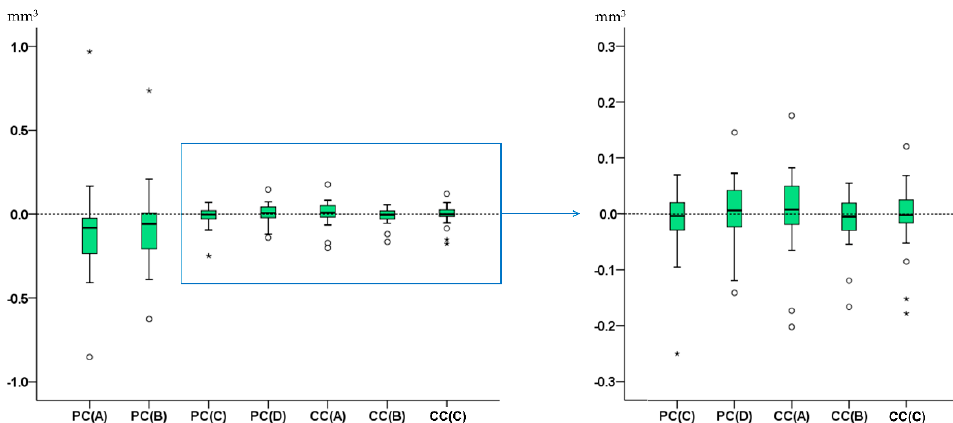
Figure 5. Box plots showing in the Y-axis the difference of each technique with the gold standard technique in tooth wear measurements. The upper limit of the black line represents the maximum value, the lower limit the minimum value, the box the interquartile range, and the horizontal black line the median value (trueness). Outliers are shown as black circles (°) or asterisks (*), in more extreme cases, with a step of 1.5 × IQR (interquartile range). Zero value (dashed horizontal line) indicates perfect agreement with the gold standard. The vertical length of each plot indicates precision. The blue box on the left image indicates the area of the graph shown in the right image in a larger scale. PC: partial crown; CC : complete crown.